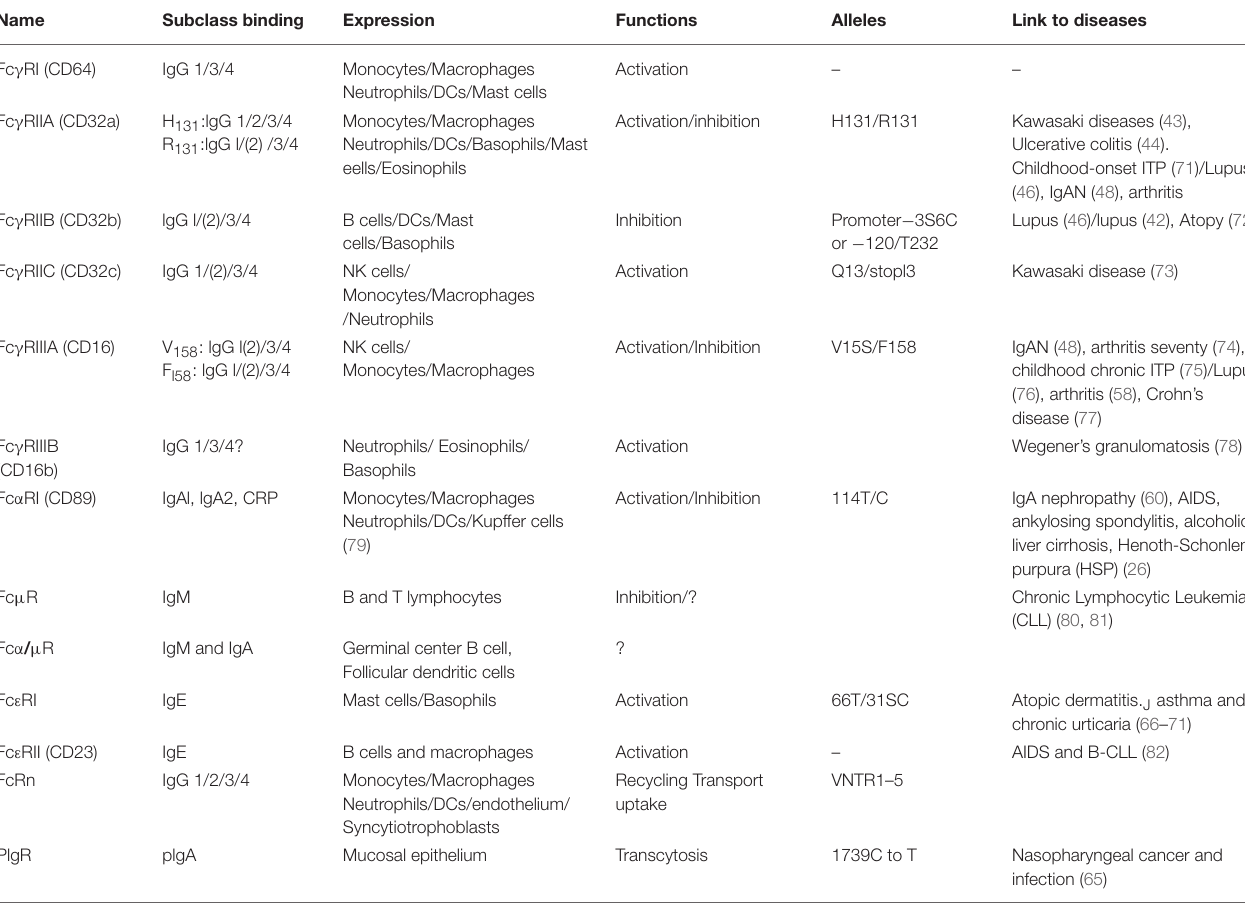
TABLE 1 | Human FcRs: their expression, function and allotypes.